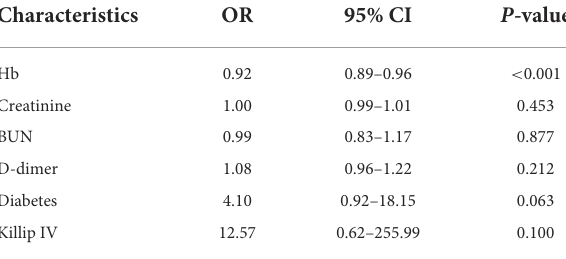
TABLE 3 Logistic regression analysis of AMI patients with in-hospital GIB.